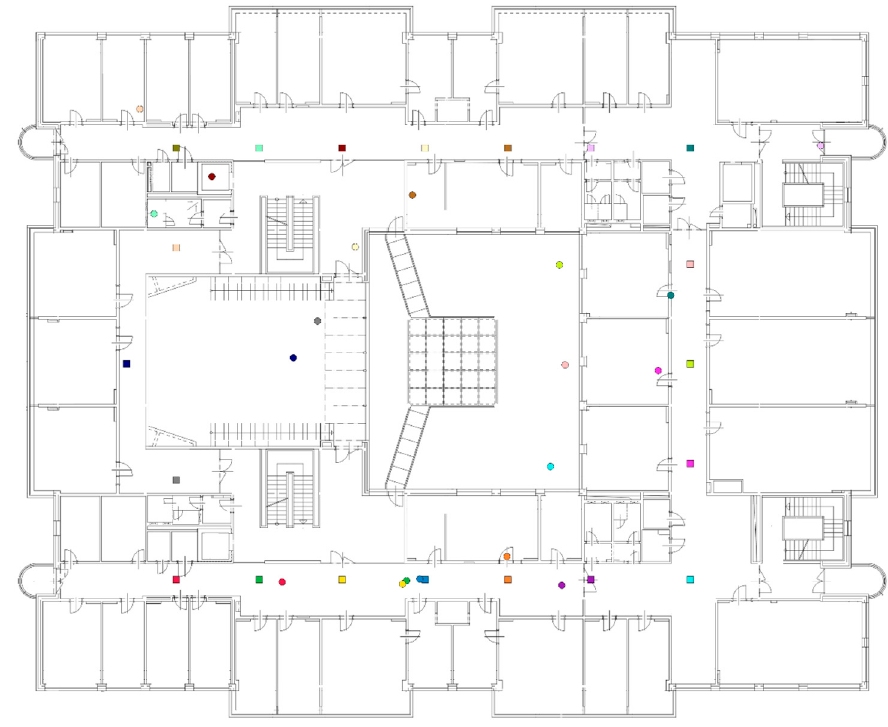
Figure 4. Visualization of test results for the Algorithm 1.